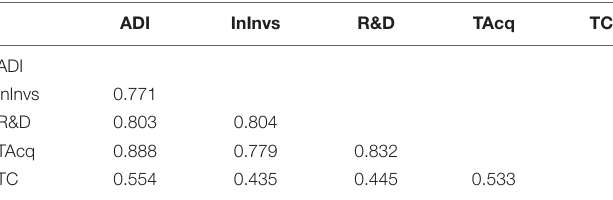
TABLE 3 | Hetero trait mono trait (HTMT) ratio.